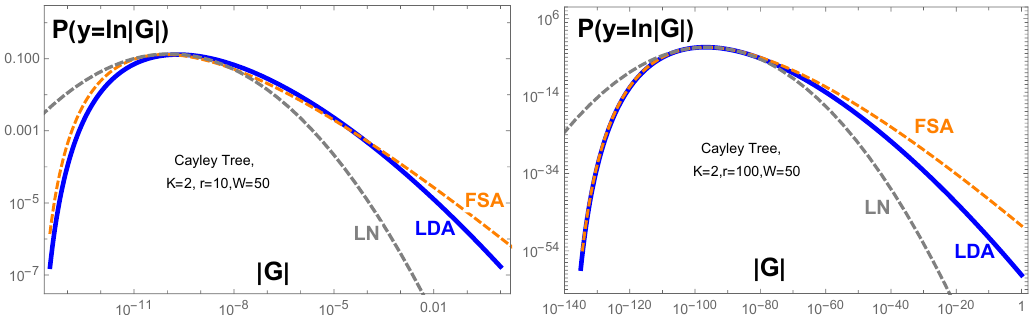
Figure 5: Comparison of PDF of y = ln | G | on the K = 2 Cayley tree for the large- W approximation (LDA), Eq. (70) (solid blue line); the Poisson distribution in FSA, Eq. (2) (orange dashed line), and the log-normal (LN) (Gaussian in ln | G | ) distribution emerging from the Central Limit Theorem in FSA (gray dashed line) for two distances r = 10 (Left panel) and r = 100 (Right panel) at W = 50. The re- < | G | < 1 of the solid blue curve corresponds to 0 < β < 1 / 2, while the gion G t yp region | G | < G corresponds to the analytical continuation of ε β to β < 0. The t yp log-log derivative d ln P ( y ) / d y = − 1 at | G | = 1 which smoothly matches the tail P ( x = | G | ) ∼ G − 2 at this point. The Poisson distribution emerging in FSA approxi- mation at a finite r overestimates the probability of large deviations | G | > G from t yp the typical value G and the error increases with increasing the distance r . In con- t yp trast, in the region | G | < G the Poisson distribution becomes more accurate as r t yp increases. The log-normal distribution is valid at small and moderate deviations from the typical value where all three distributions nearly